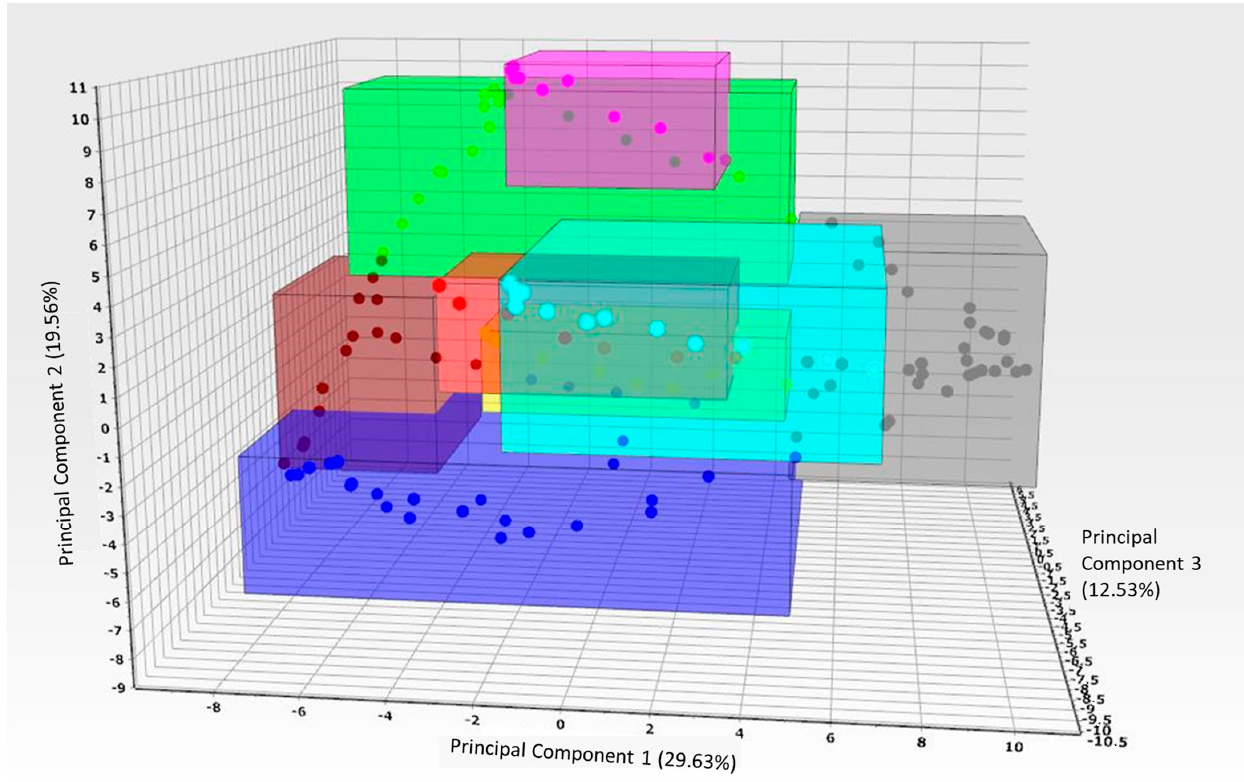
Figure 33. PCA analysis of binary, ternary, and quaternary mixtures containing all six different lithium minerals, and orthoclase and quartz, one cluster is formed containing two mica minerals.